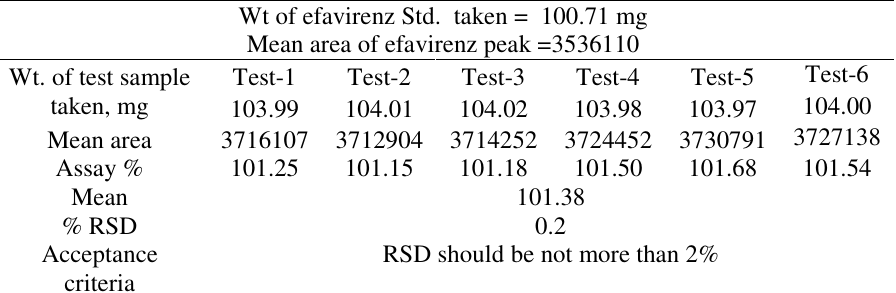
Table 2. Precision data for developed